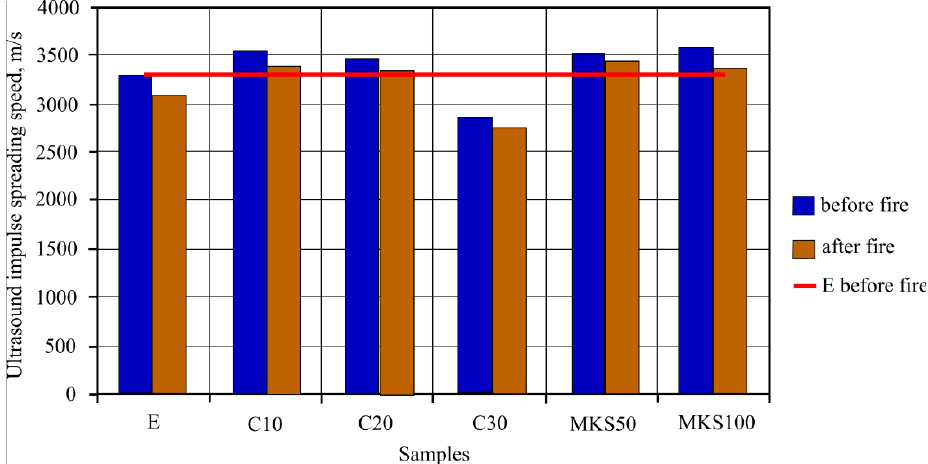
Figure 9. Sample ultrasound impulse spreading speed research results. Sample absorption kinetics were determined and shown in Figure 10. Research re- 21.35%. The smallest absorption was of MKS50 samples and was equal to 15.12%. All sam- ple absorption, except for C30, when compared to E samples, was smaller.